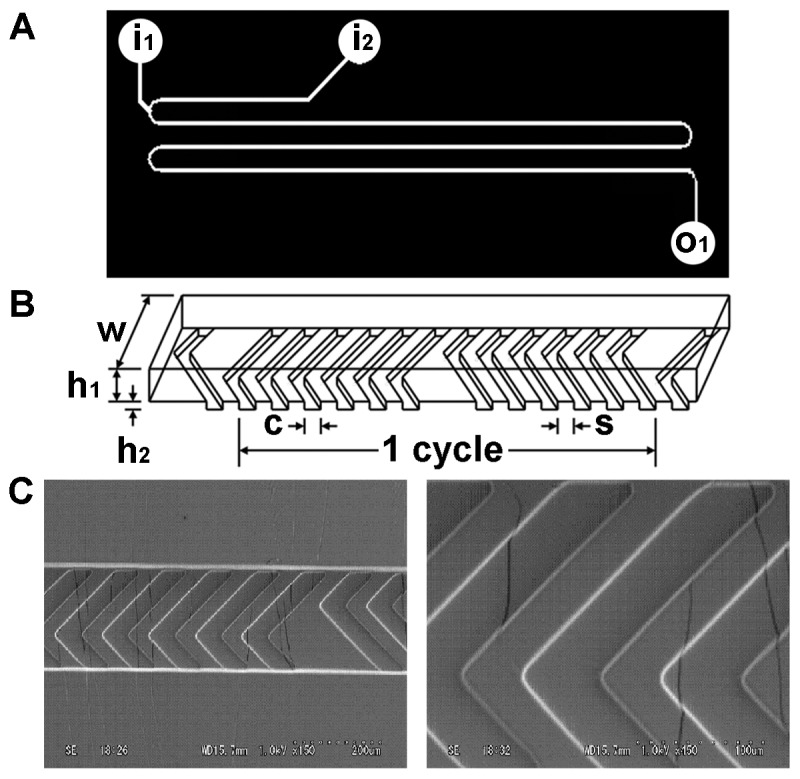
Structure of the microfluidic chip with a chaotic mixer array.(A) Two-dimensional design of the chip: i1, an inlet for f-NA and STR-R8; i2, an inlet for SUV and D-MEND; o1, an outlet. (B) Schematic diagram of the staggered chaotic mixer: h1=75 µm, w=200 µm, h2=25 µm, c=50 µm, s=50 µm. (C) SEM images of the parts of the staggered chaotic mixers and herringbone ridges in the reaction channel: 150× (left) and 450× (right). The SEM images show the fabricated staggered chaotic mixer array and herringbone ridges.